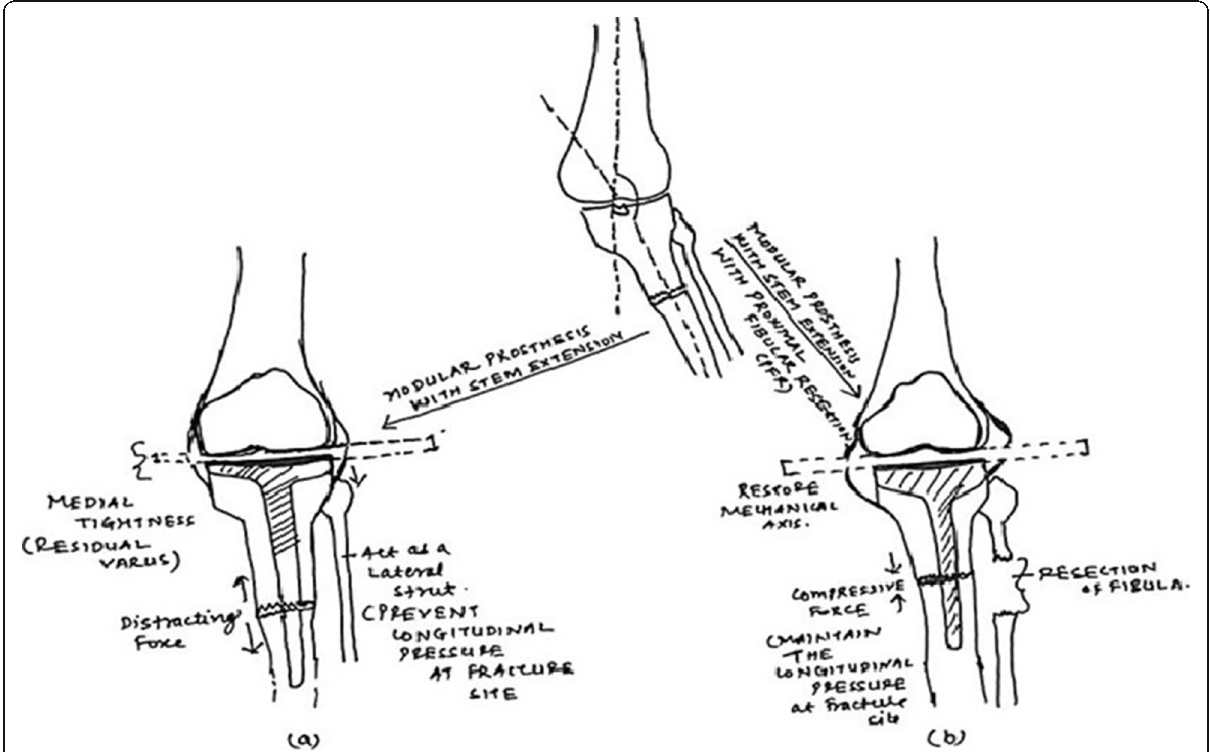
Fig. 7 Schematic diagram showing the proposed hypothesis. The diagram showing that a ) the intact fibula acts as a strut and produces distraction forces at the fracture site and hinders the efficient decompression of medial compartment; b ) proximal fibular osteotomy facilitates precise correction of deformity, improves the adverse biomechanics, decompresses the medial compartment more efficiently, and provides desirable biomechanical environment at fracture sites that enhances